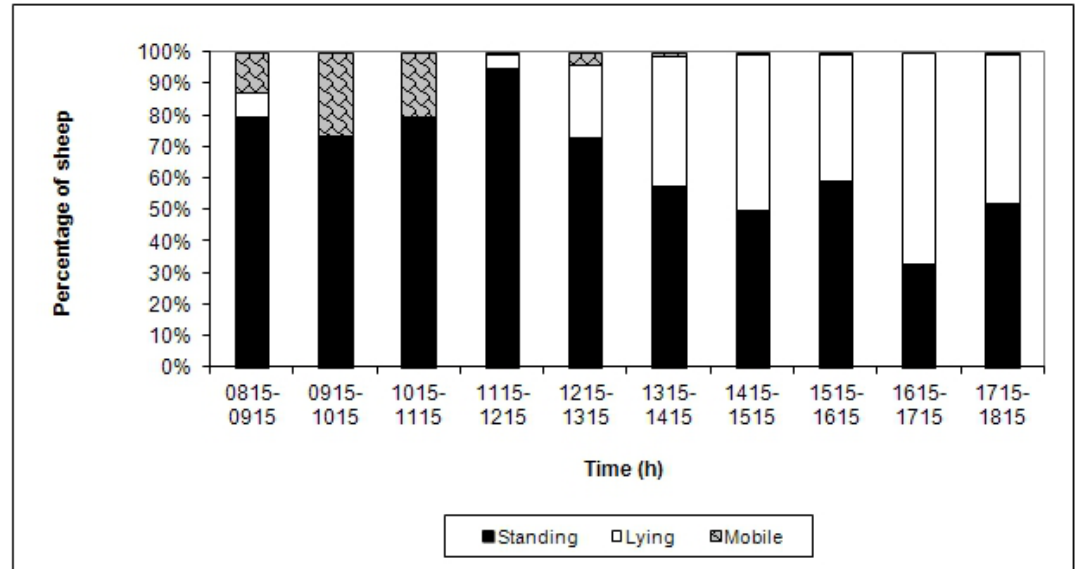
Figure 1. Mean percentage of sheep displaying the postures of standing, lying and mobile at each 15-min sample point during each h of observation over 2